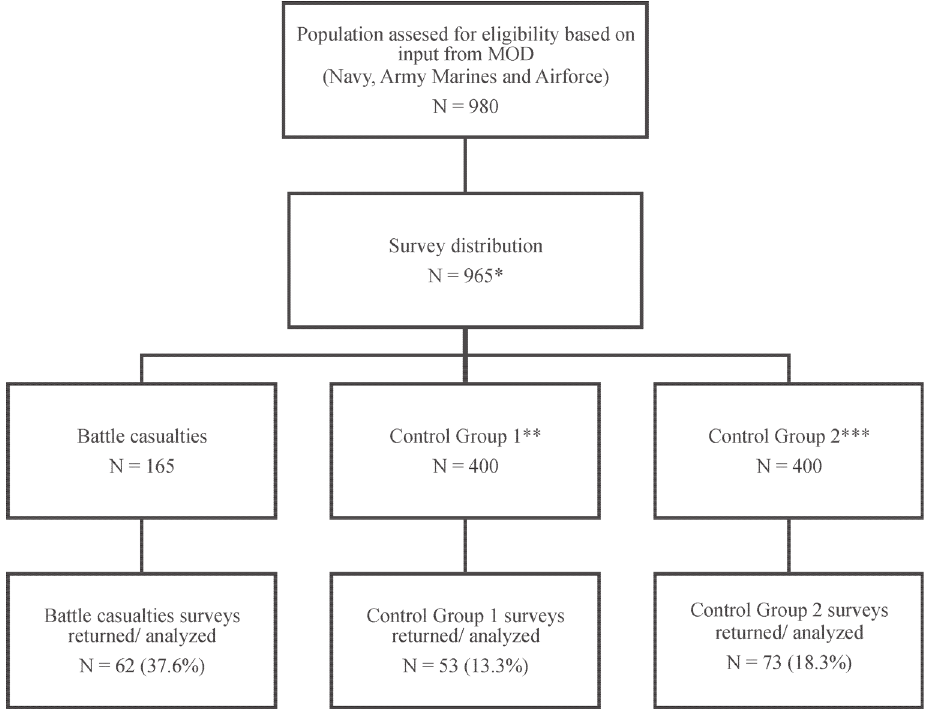
Fig 1. CONSORT diagram for questionnaire Dutch battle casualties and control group deployed to Southern Afghanistan.